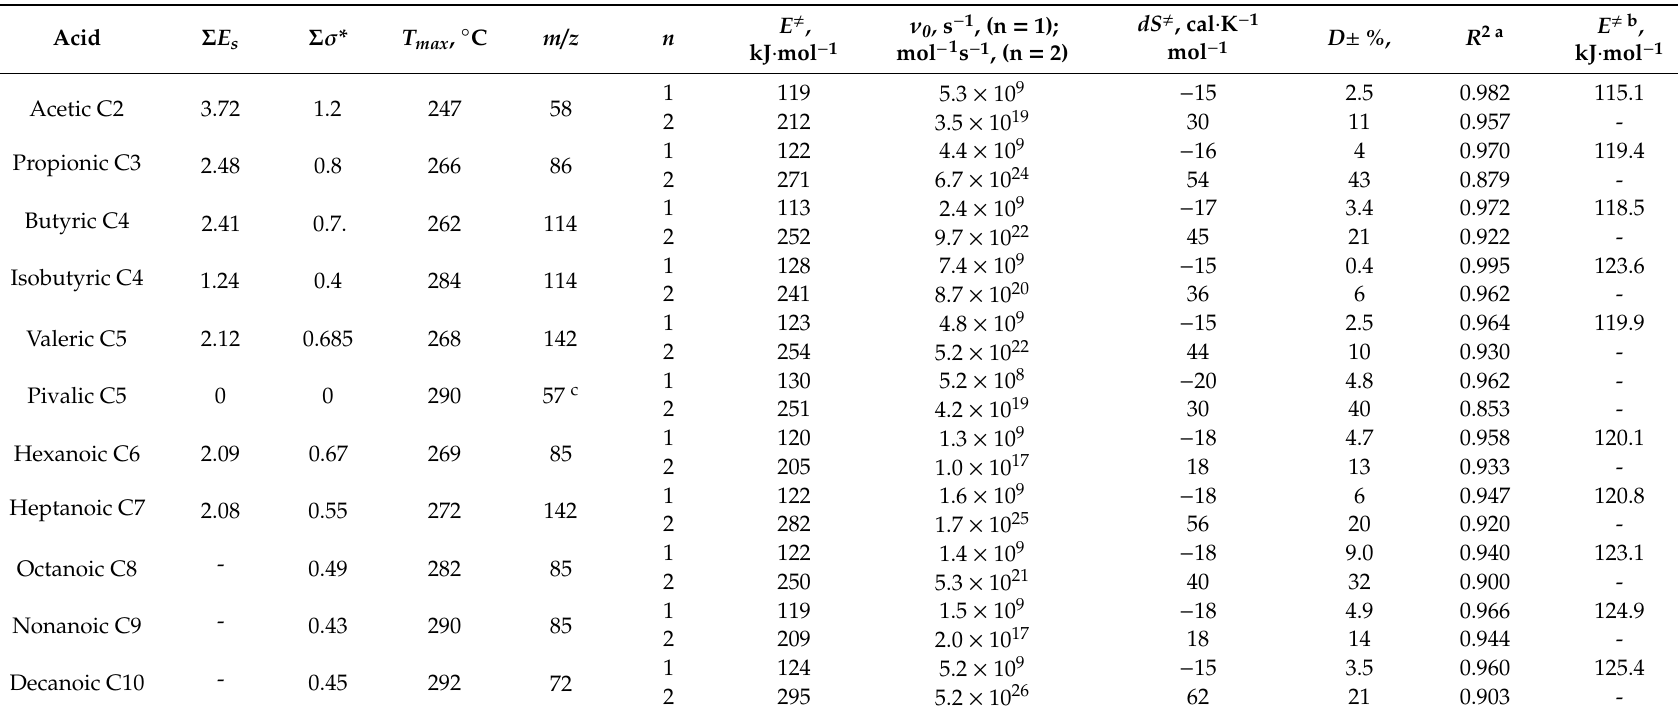
Table 1. Kinetic parameters (temperature of the maximum desorption rate T max , reaction order n , activation energy E (cid:44) , pre-exponential factor ν 0 and activation entropy dS (cid:44) ) of ketonization of reaction series of carboxylic acids on the lCeSi surface (0.6 mmol / g). Sum of the Taft Induction Constants ( (cid:80) E s ) of the Substituents at the Reaction Steric Constants (